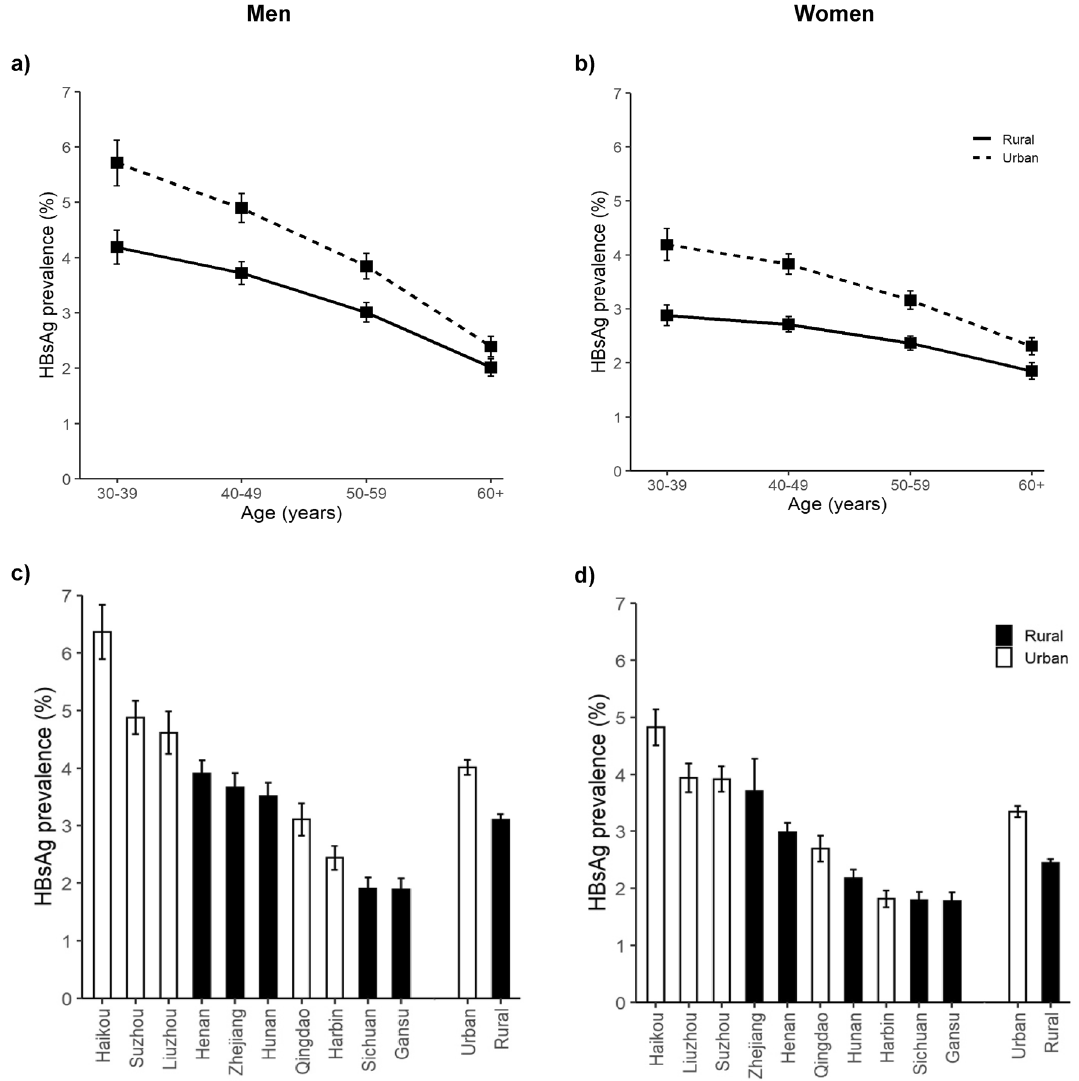
HBsAg prevalence in women by study site. HBsAg, hepatitis B surface